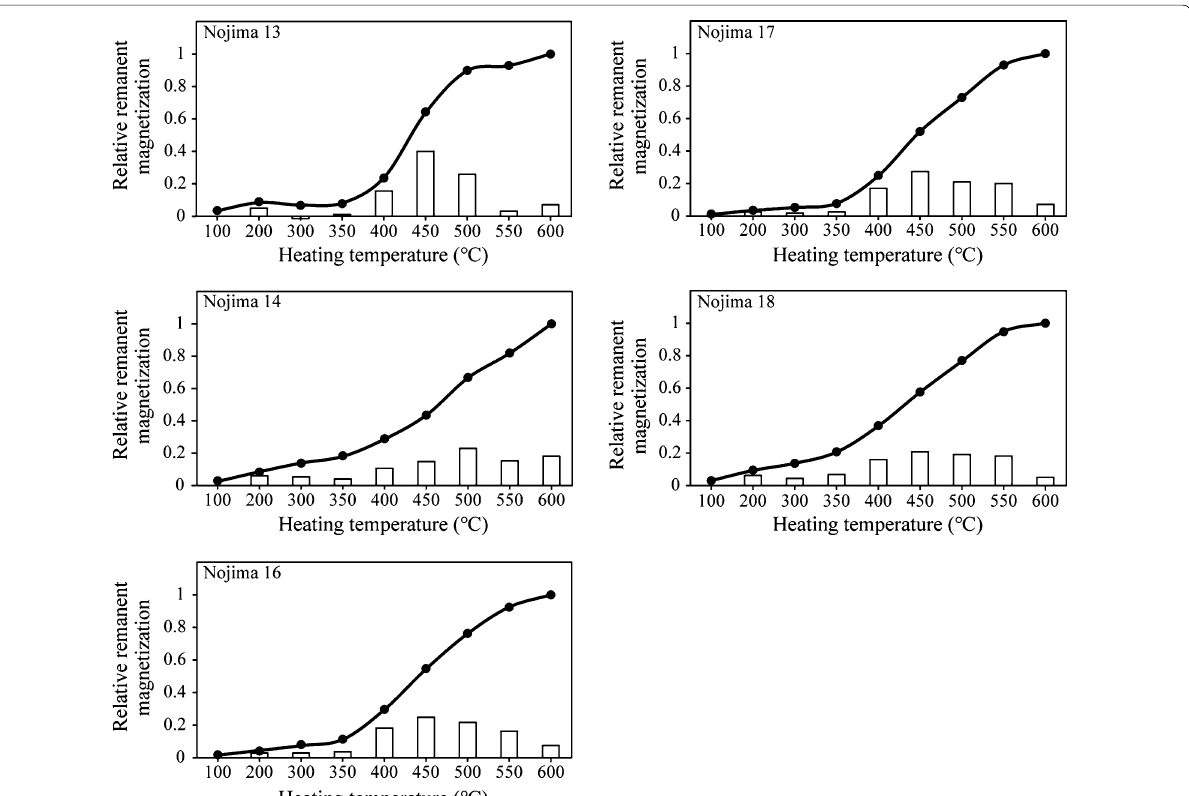
Fig. 4 Relative remanent magnetization of the five fragment gouge samples after stepwise heating experiment at 100 μT, normalized with respect to maximum magnetization at 600 °C. The histograms show the amount of partial remanent magnetization acquired during heating (e.g., at 400 °C, the histogram indicates the amount of remanent magnetization acquired between 350 and 400 °C). The raw data are shown in Additional file 1: